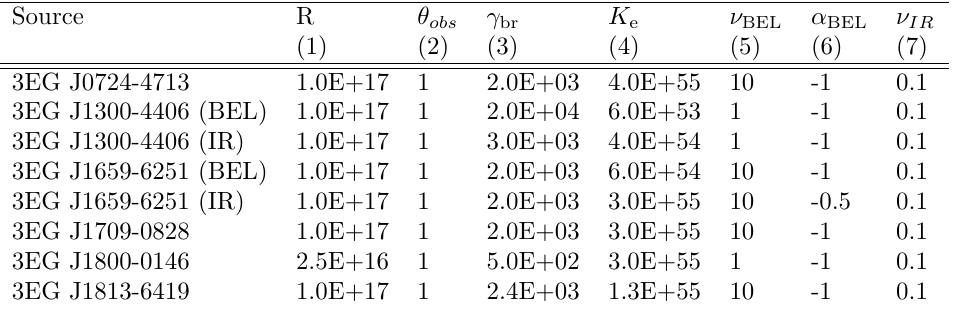
Table 2: Parameters related to the EC models for the respective